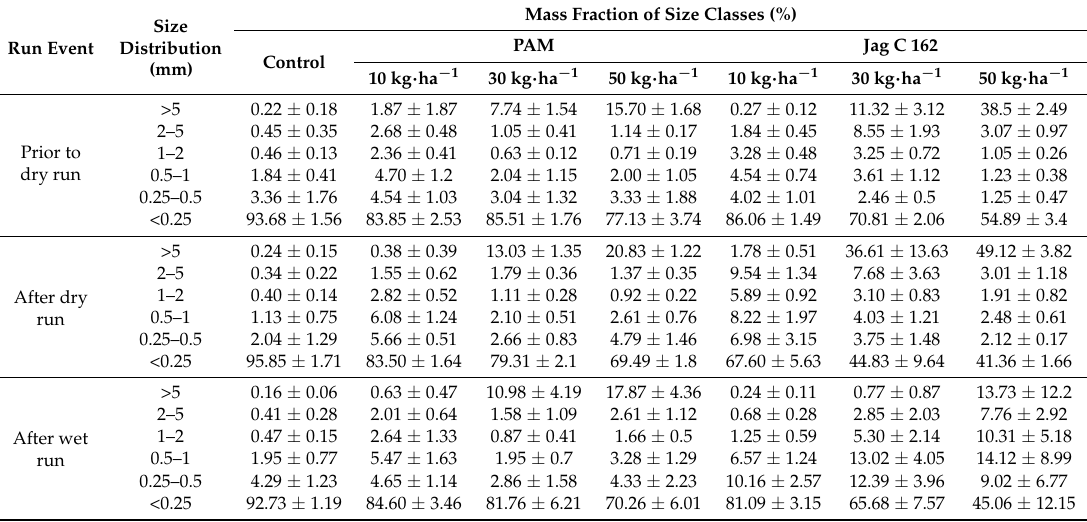
Table 3. Size distribution of soil aggregates from soil surface treated with different concentrations of PAM and Jag C 162. Subscripts indicate the standard deviation of the six